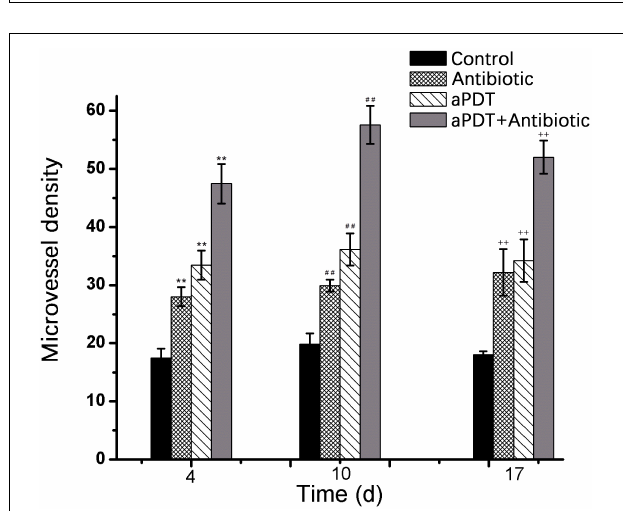
FIGURE 12 | Blood vessel density (measured by the expression of CD31) in tissues of burn wound sites as determined by immunochemistry [* p < 0.05, ** p < 0.01 vs. control group (4 days); # p < 0.05, ## p < 0.01 vs. control group (10 days); + p < 0.05, ++ p < 0.01 vs. control group (17